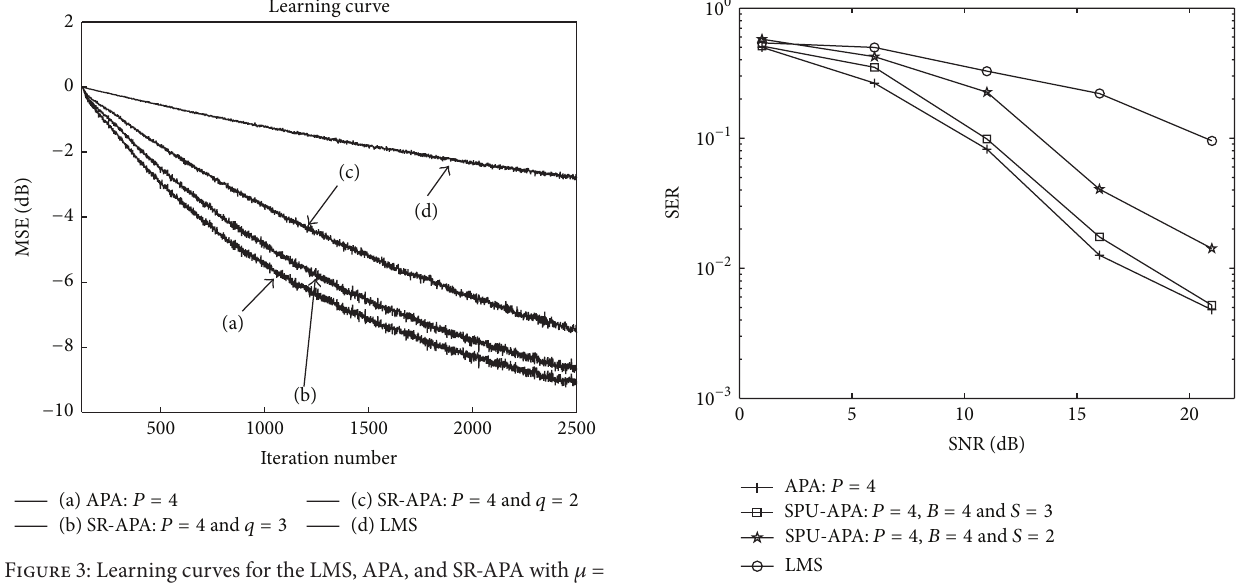
Figure 5: Symbol error rate versus SNR for APA and SPU-APA.